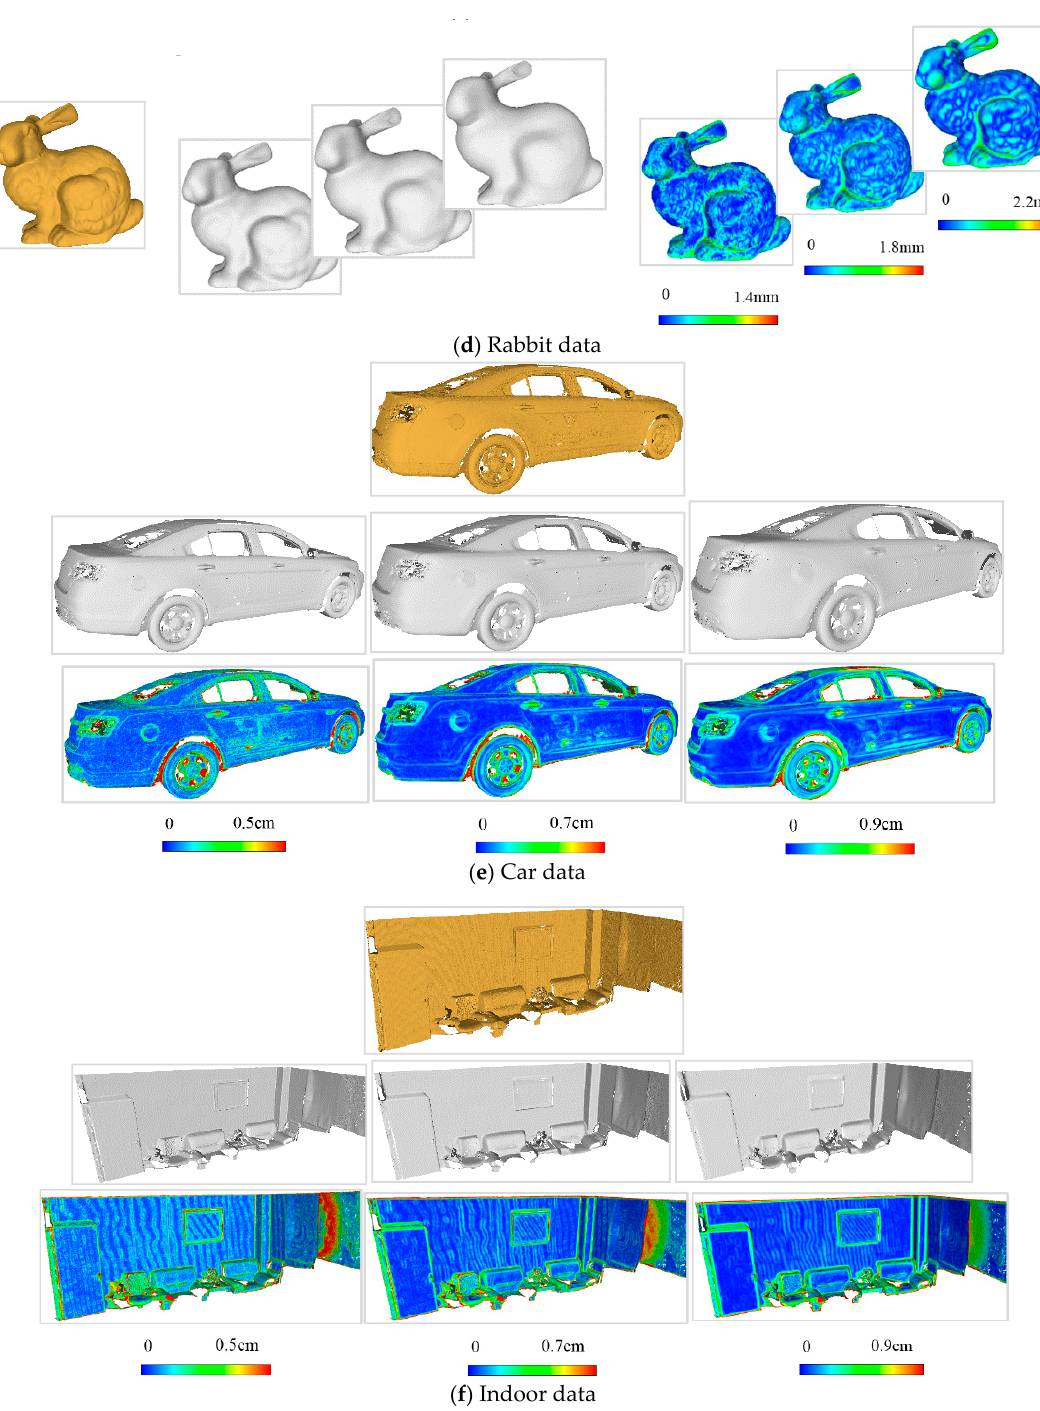
Figure 10. Gaussian smoothing results of three levels and corresponding surface variation rendering.